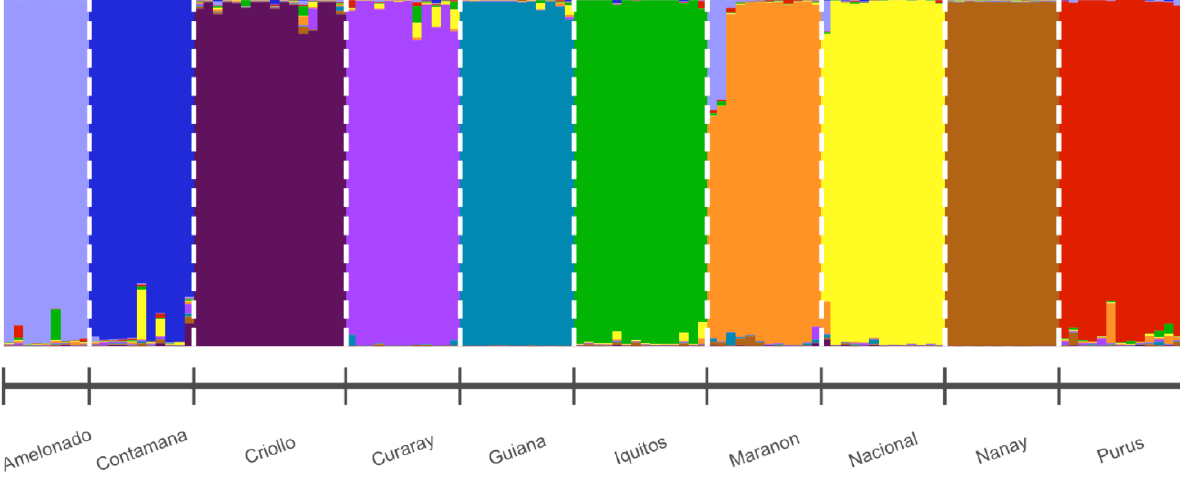
Figure 6. Population structure of Theobroma cacao L. of the 116 reference accessions along with 8 representative Honduran pure Criollo samples based on 16 SSR markers, using K = 10 according to the second best ∆ K. Each individual sample is represented by a vertical line divided into K colored segments that represent the membership fraction for each cluster. The bar line under the plot represents the ten genetic groups identified by [17]. The 8 representative Honduras pure Criollo samples cluster with the Amazon Criollo reference accessions.